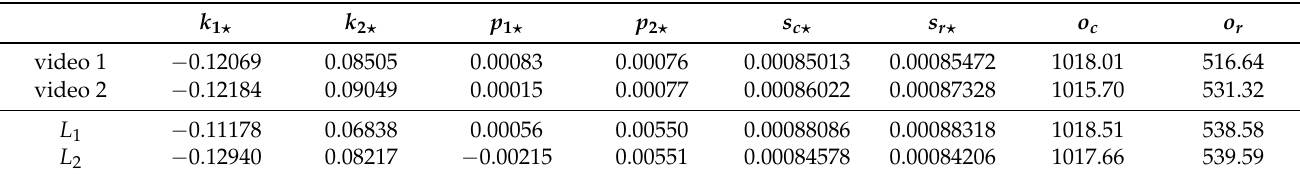
Table 1. Intrinsic parameters thta were obtained from videos 1 and 2 (with n I = 5) and in laboratory conditions ( L 1 = indoors; L 2 = outdoors and with high obliquity).